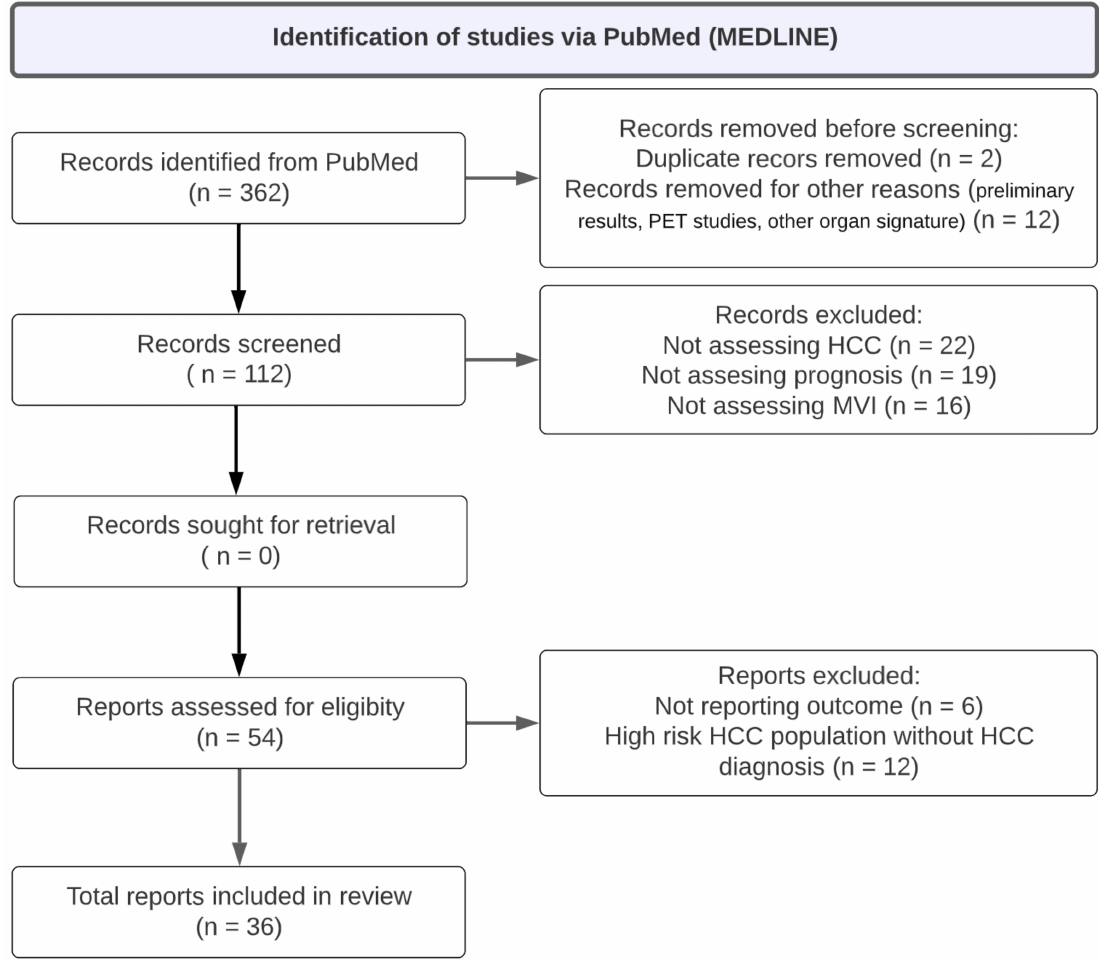
Figure 1. Flow diagram of the study selection